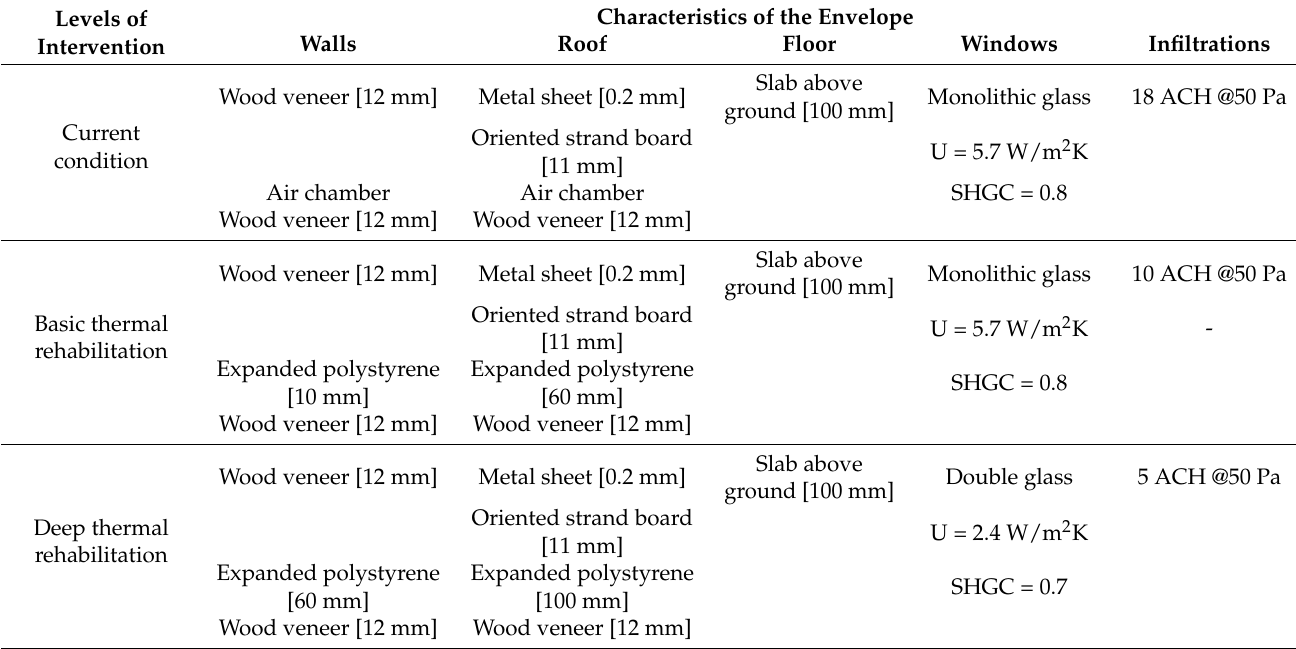
Table 6. Definition of the thermal energy